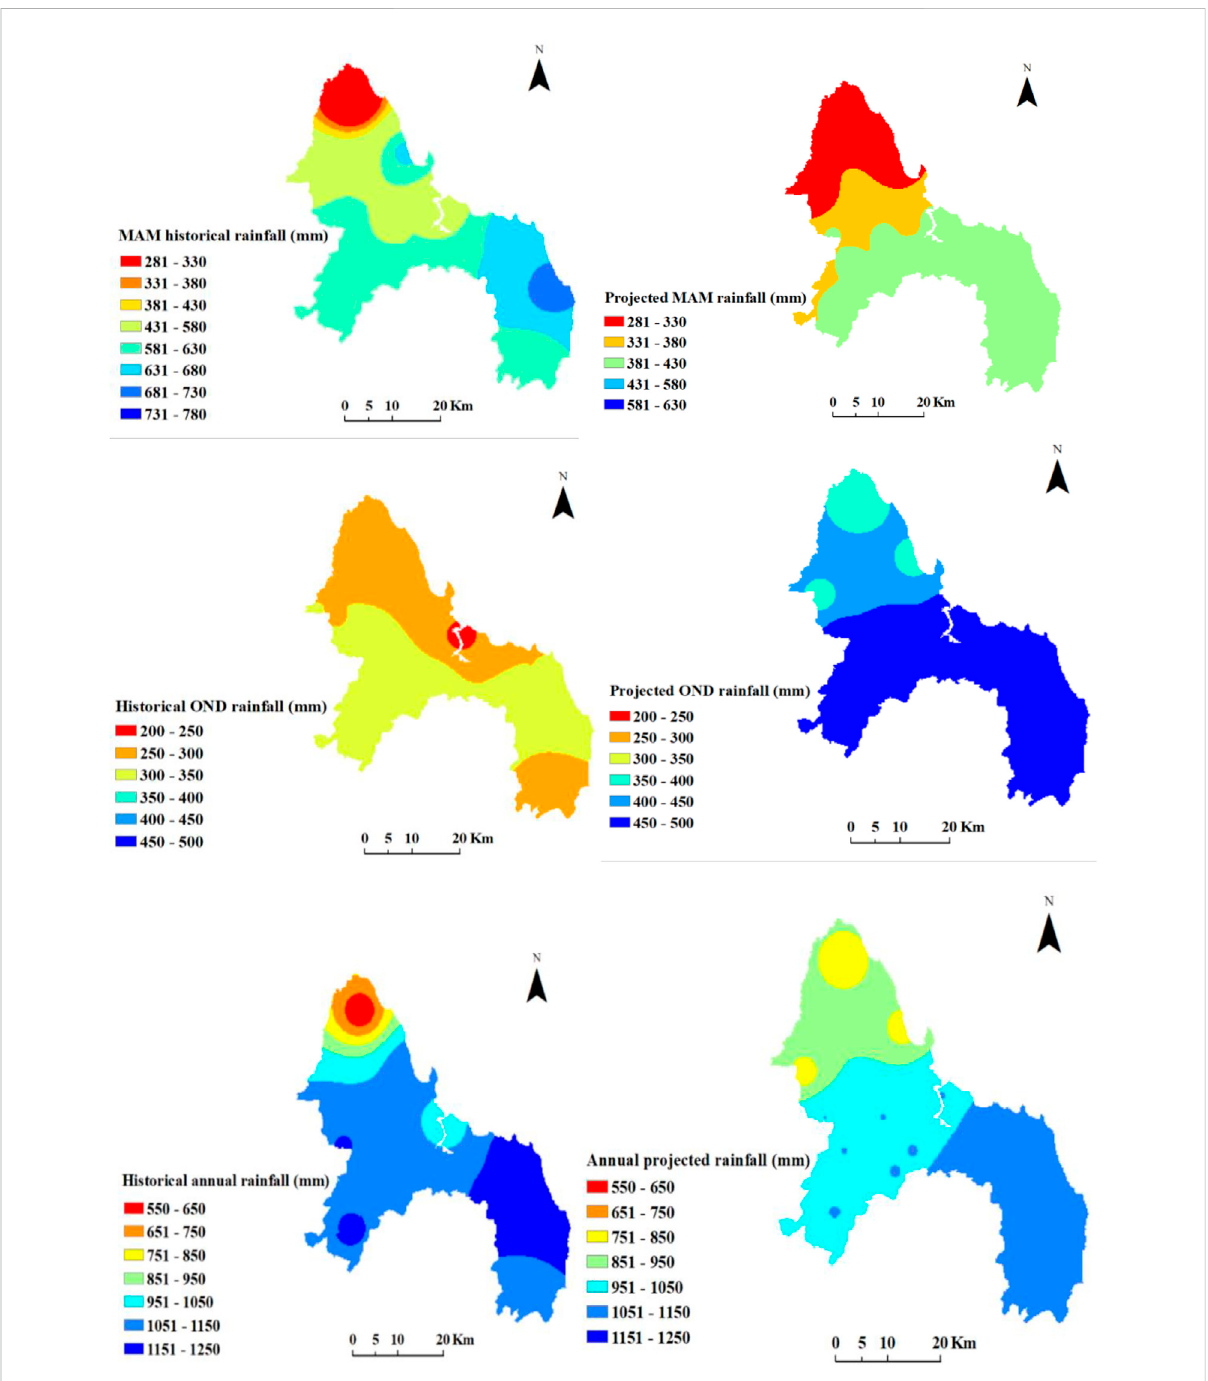
FIGURE 5 Spatial distribution of historical and projected rainfall at a season (MAM and OND) and annual